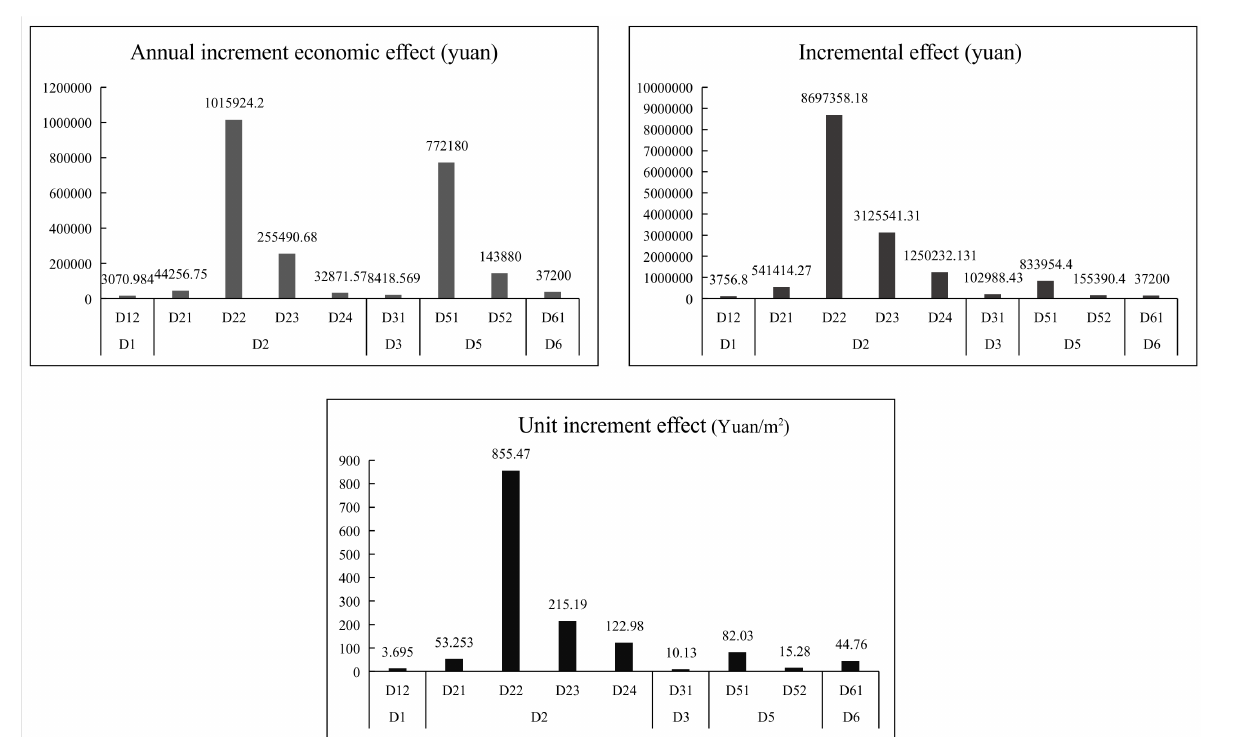
Figure 3. Green building energy-saving technology in incremental effect